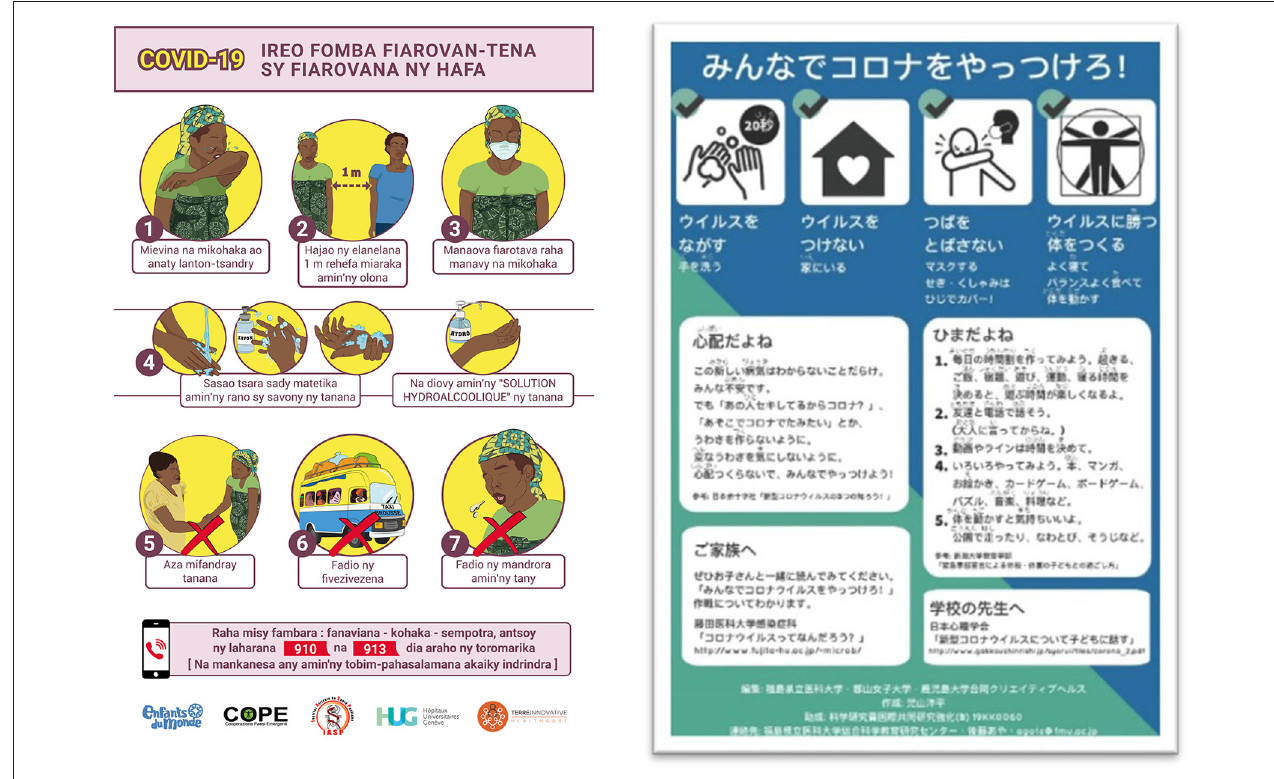
FIGURE 1 | Poster for pregnant women and Leaflet for